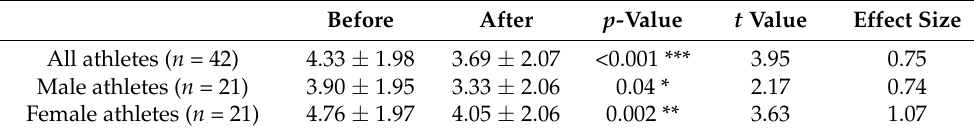
Table 2. The LESS scores of participants before and after dynamic taping. Before After p- Value t Value Effect Size All athletes ( n = 42)